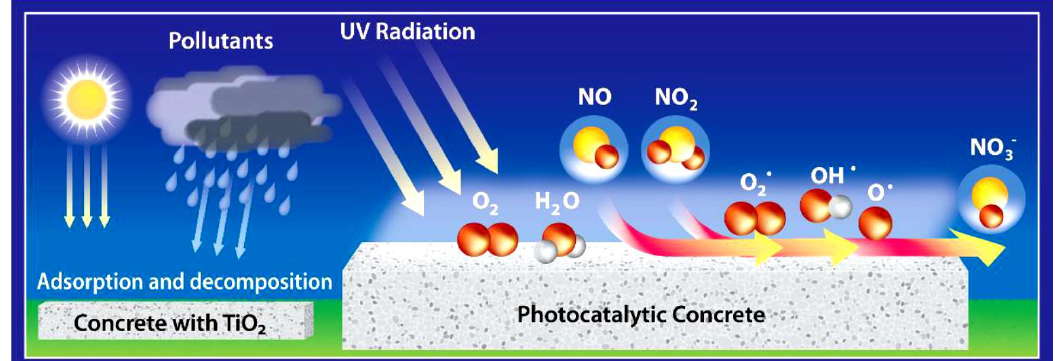
Figure 10. Schematic illustration of NO x removal by photocatalysis concrete pavement [94].